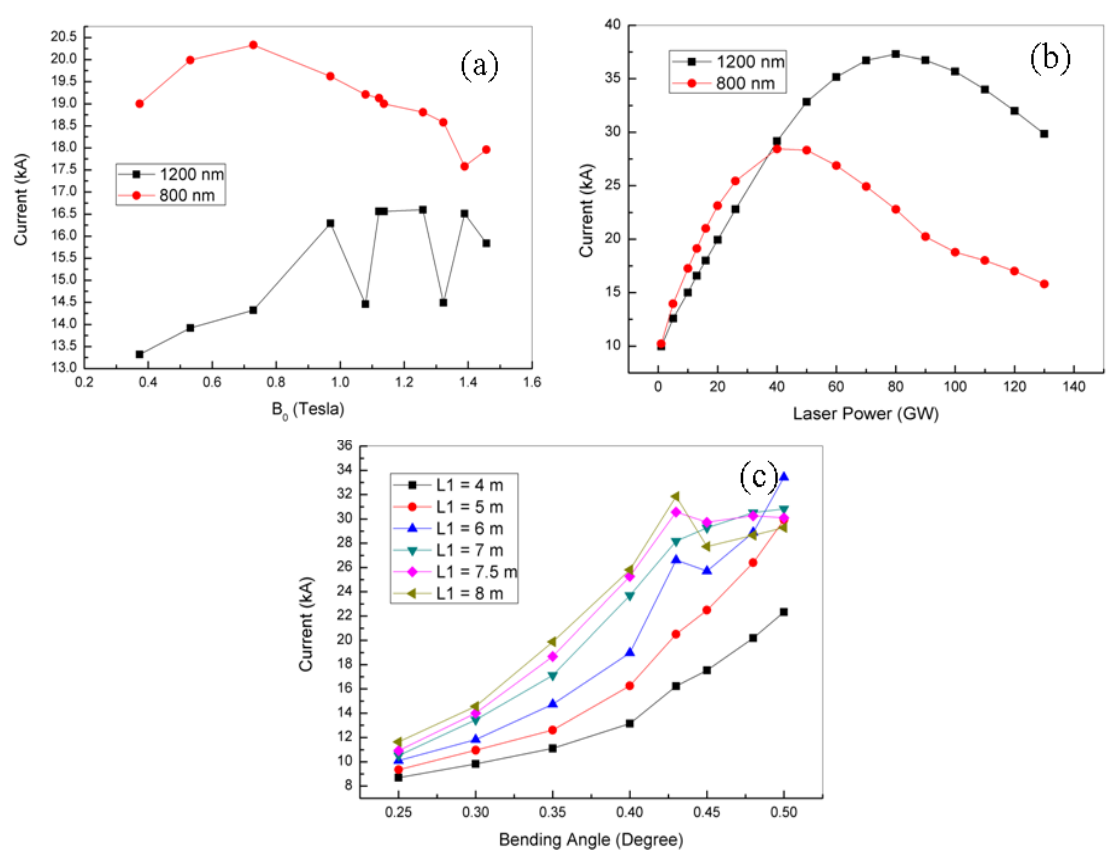
Figure 7. (Color online). The variation of the main peak current after chicane. ( a ) The effect of the wiggler field, B , for two different laser wavelengths, 800 nm and 1200 nm. 0 ( b ) The effect of laser power for two different laser wavelengths, 800 nm and 1200 nm. ( c ) The effect of the bending angle and the length between dipole magnets (L 1